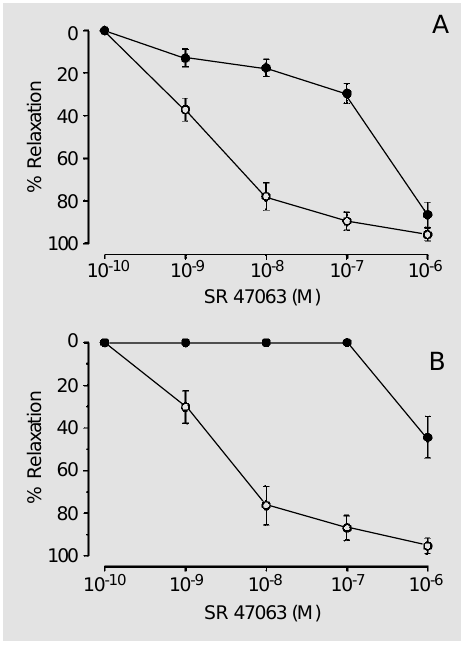
Figure 1 - Relaxant effects of SR 47063 on human saphenous vein precontracted with 20 mM KCl (A) and 10 µM noradrenaline (B) in the presence (filled circles) and absence (open circles) of 3 µM glibenclamide. Data are re- ported as means ± SEM (N = 6- 11).